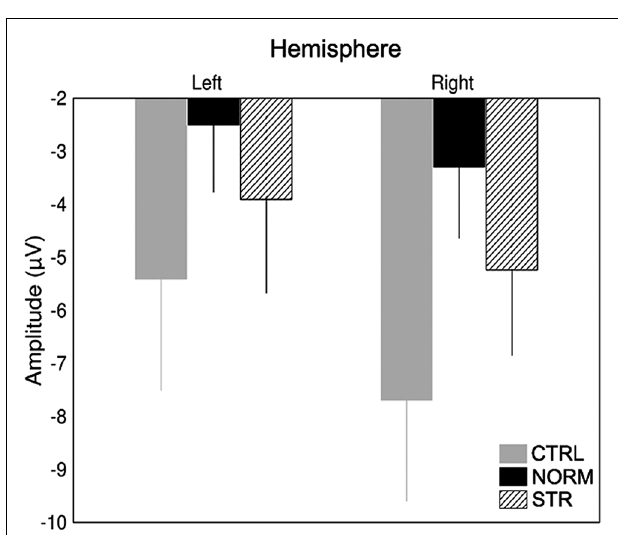
FIGURE 5 |Average ( ± SE) amplitude of the N170 component for the two hemispheres and CTRL (gray), NORM (black), and STR (striped) conditions